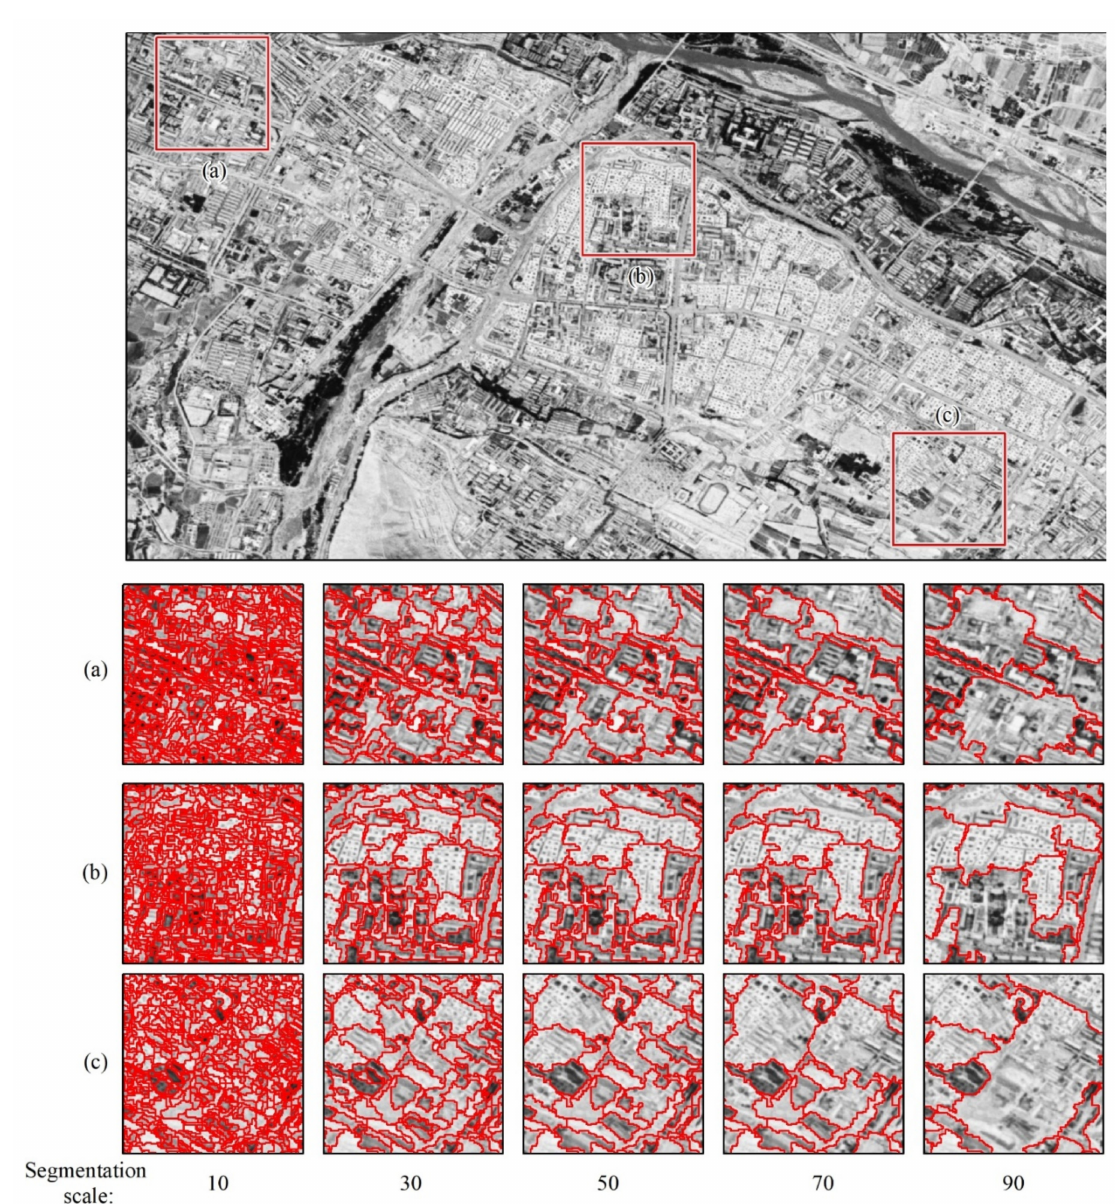
Figure A1. Segmentation results at different spatial scales. ( a – c ) are three sub-regions listed in the top